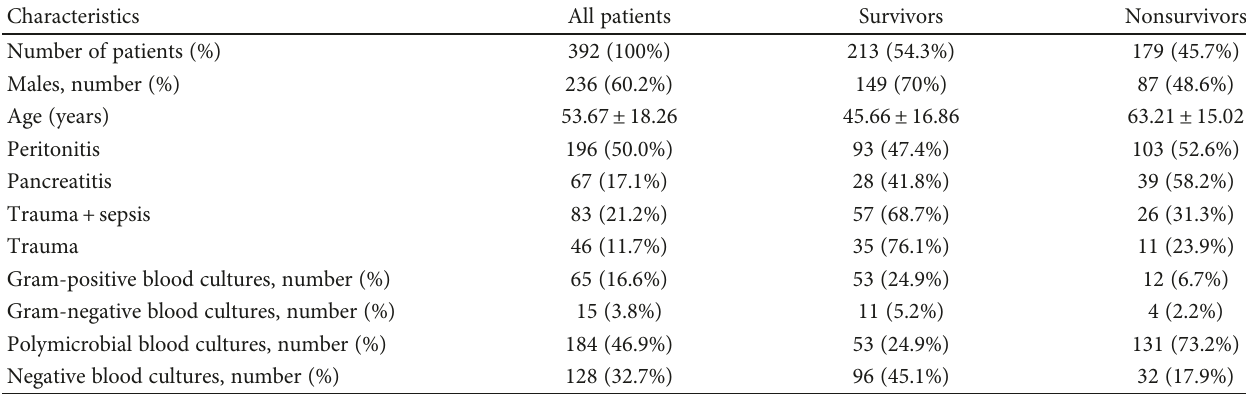
Table 1: Baseline characteristics of all patients according to outcome.